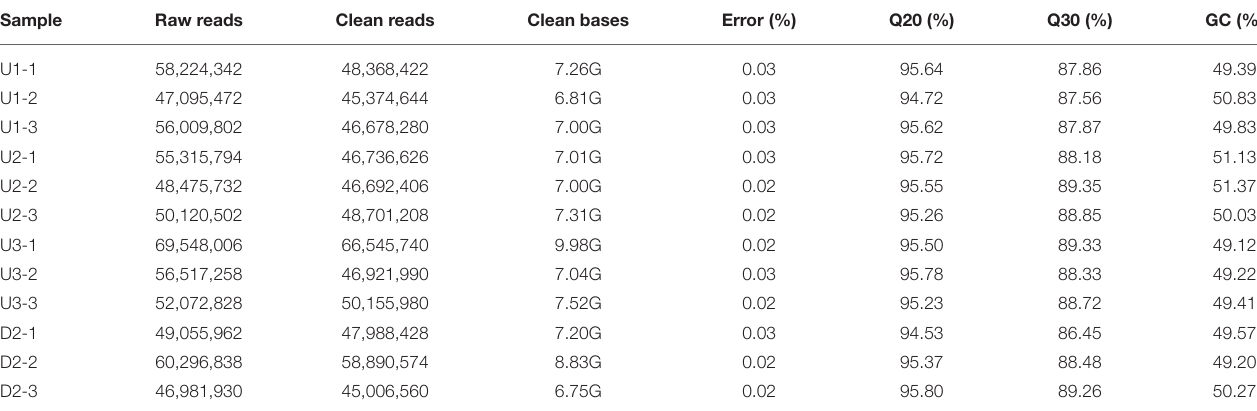
TABLE 1 | Summary of RNA-Seq data from leaf axils in the upper (U) and lower (D) stems of L. lancifolium. Sample